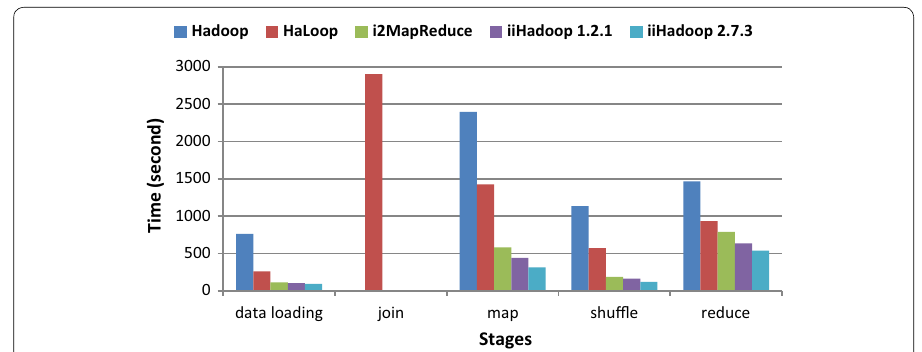
Fig. 7 Running time of different stages in PageRank